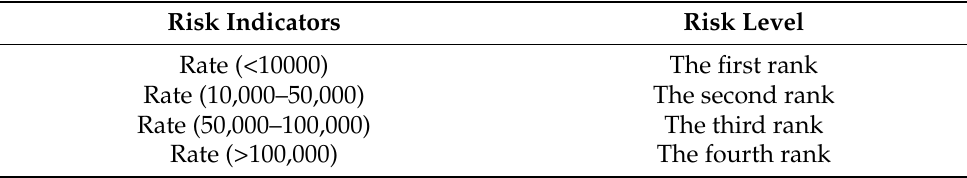
Table 2. Risk indicators of the rate.